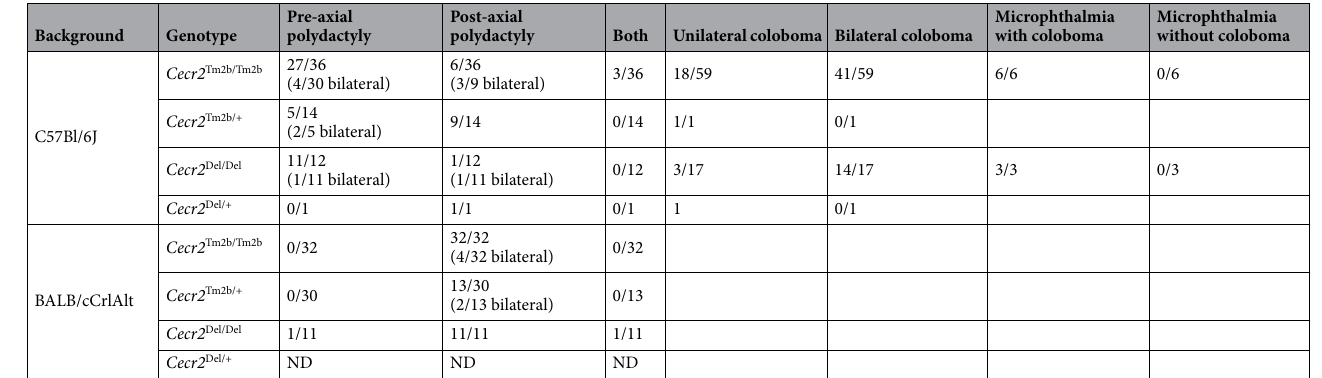
14/197 embryos with polydactyly (7.1%,), with 5/197 pre-axial (2.5%), 9/197 post-axial (4.6%) and 0/197 with both. In the BALB/cCrlAlt background with the Cecr2 Tm2b mutation, only post-axial polydactyly was observed (Fig. 3a). In Cecr2 Tm2b/Tm2b embryos 32/48 showed polydactyly (67%). We also observed post-axial polydactyly in 13/131 Cecr2 Tm2b/ + heterozygotes (9.9%). The Cecr2 Del mutation on both the BALB/cCrlAlt and C57Bl/6N backgrounds showed similar results, although